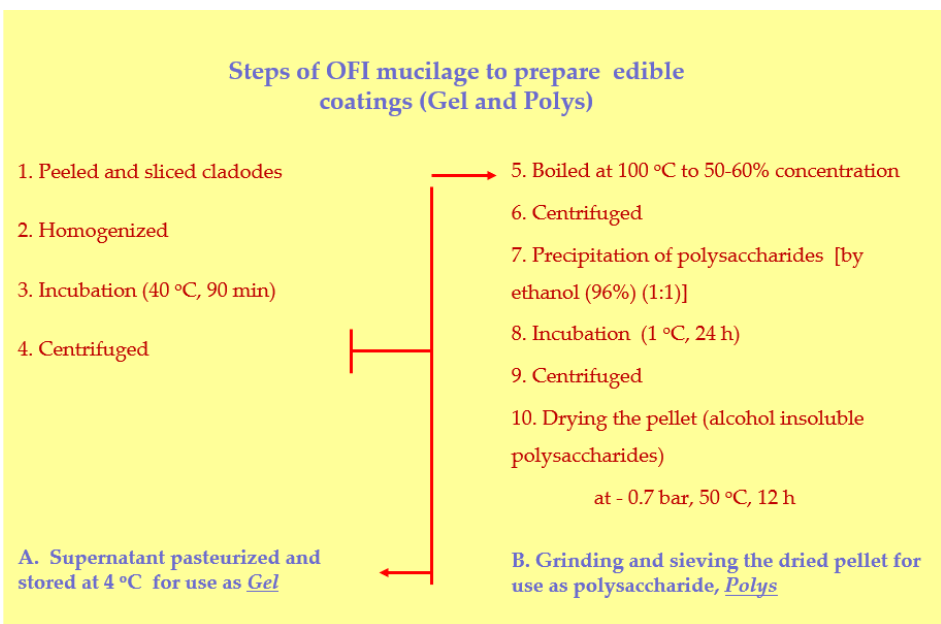
Figure 1. Diagram of the steps during preparation of edible coatings (ECs) from cladodes of Opuntia ficus-indica (OFI). A, the alcohol insoluble polysaccharides content, called Gel; B, the alcohol insoluble polysaccharides content, called Polys.